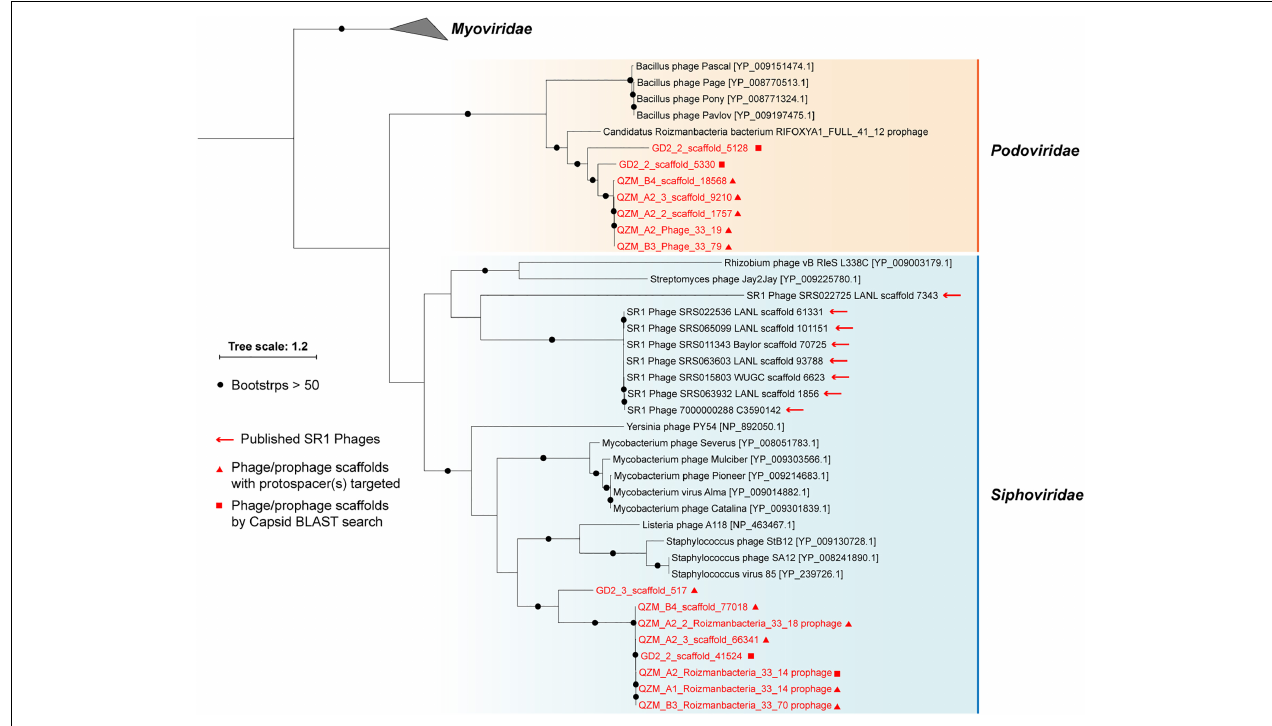
FIGURE 3 | Phylogeny of capsid proteins used for taxonomic assignment of Roizmanbacteria-infecting phage (or prophage) in this study. The Roizmanbacteria-infecting phage and prophage are shown in red, and those with spacer targets are indicated by triangles. Squares indicate phage determined to be similar based on their capsid protein sequences. The previously reported Absconditabacteria (SR1) phage are included for comparison.